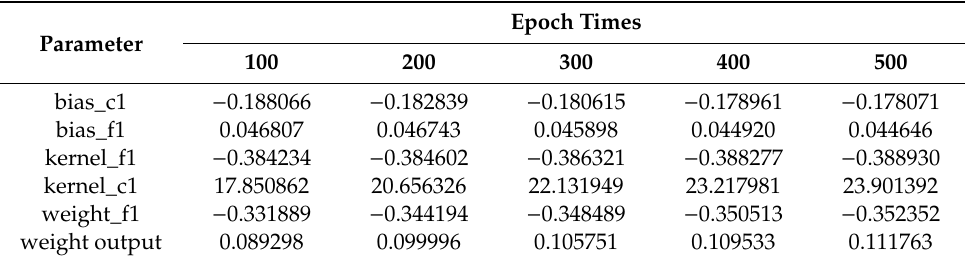
Figure 12. Input image of 12 separated current waveforms. In the process of identification using the convolutional neural network model, the signature maps extracted from the input data after the first convolutional operation are shown in Figure 13. It can be seen from the figure that the contour edge and other features of each load current waveform in Figure 12 are strengthened and extracted by the kernel in the convolutional layer.